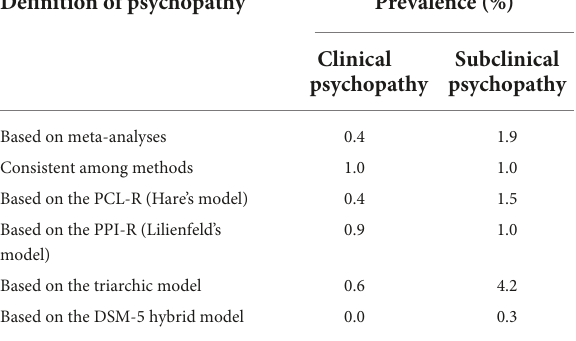
TABLE 2 Prevalence of clinical psychopathy and subclinical psychopathy in the sample of participants (N = 682) as a function of the different definitions of the psychopathy